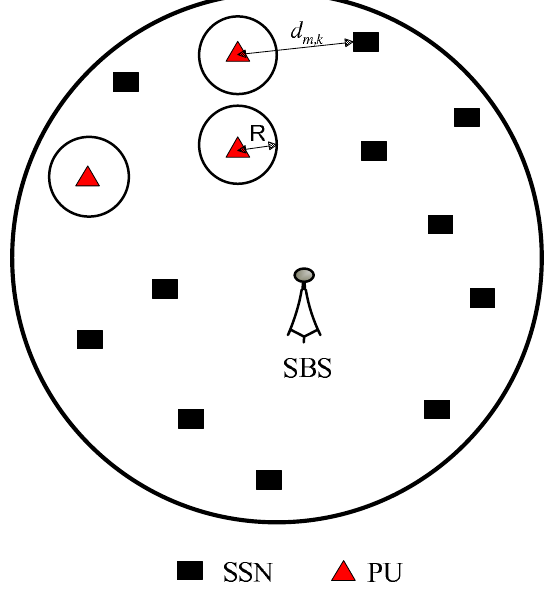
Figure 1. A cognitive radio system model with a secondary base station (SBS), secondary sensor nodes (SSNs) and primary users